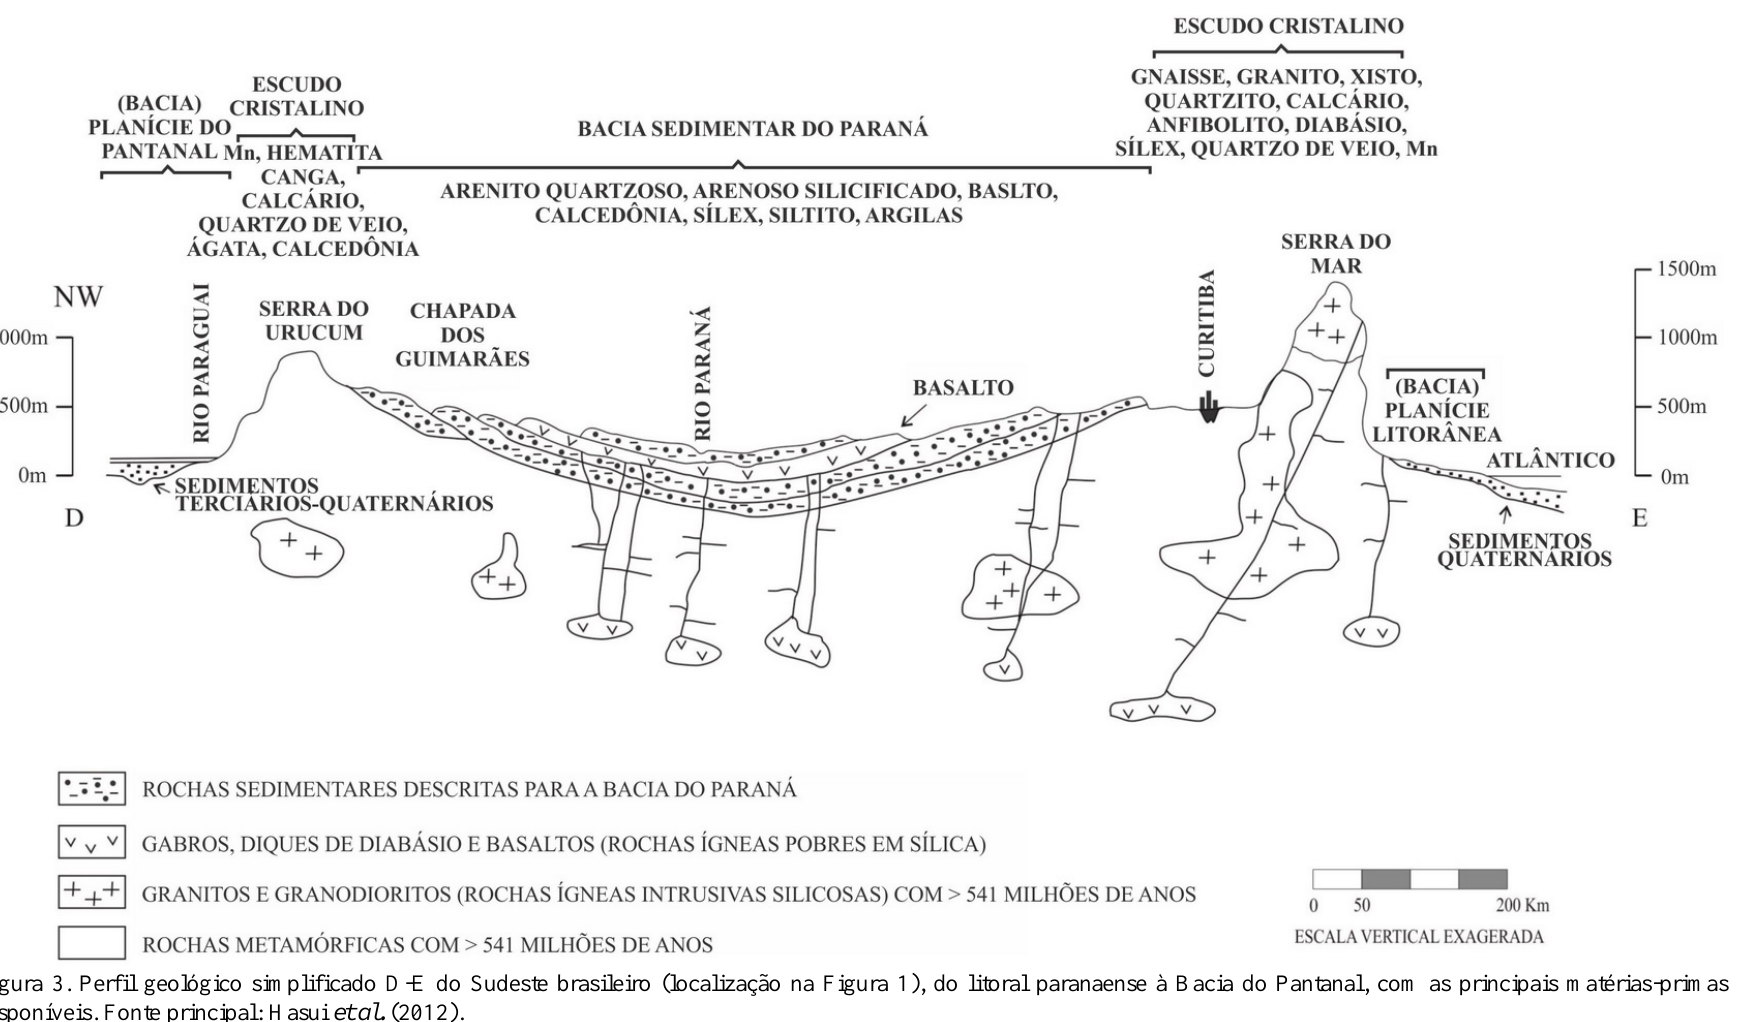
Journal of Lithic Studies (2017) vol. 4, nr. 3, p. 189-216 doi:10.2218/jls.v4i3.1624